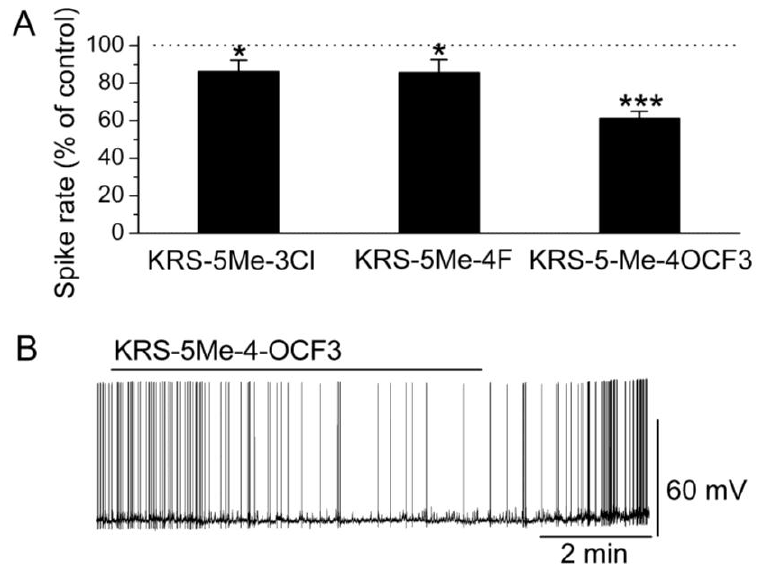
Figure 6. Anilino enaminones depress the spiking activity of mitral cells. ( A ) Normalized bar graph shows inhibition of spiking of mitral cells in response to bath application of KRS-5Me-4-OCF 3 (20 μM), KRS-5Me-3Cl (20 μM), and KRS-5Me-4F (20 μM). Responses to enaminones are normalized with respect to control conditions (* p < 0.05, *** p < 0.001). ( B ) Original recording from a representative mitral cell illustrates the inhibition in firing rate and hyperpolarization following application of KRS-5Me-4-OCF 3 . From